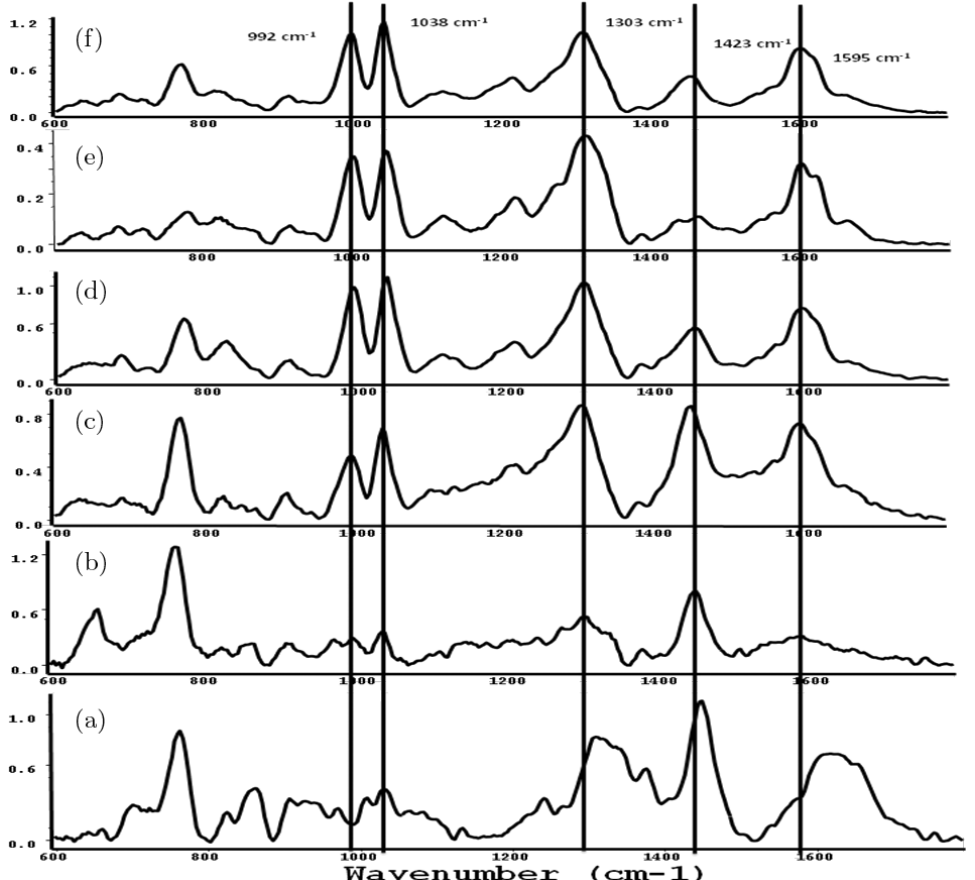
Fig. 4. Representative spectra for SERS approach in drug-spiked milli-q. SERS approach to achieve therapeutically relevant concentrations was ¯rst investigated in milli-q. Concentrations ranging from 1 – 0.001 mg/mL were spiked in milli-q and deposited on suitable nanoparticle substrates. Imatinib-speci¯c signals could also be detected in the lowest concentration. (a) Blank nano- particles, (b) Lowest concentration: 0.001 mg/mL (1 (cid:1) g/mL), (c) Concentration: 0.01 mg/mL, (d) Concentration: 0.1mg/mL, (e) Concentration: 0.5 mg/mL, (f) Highest concentration: 1